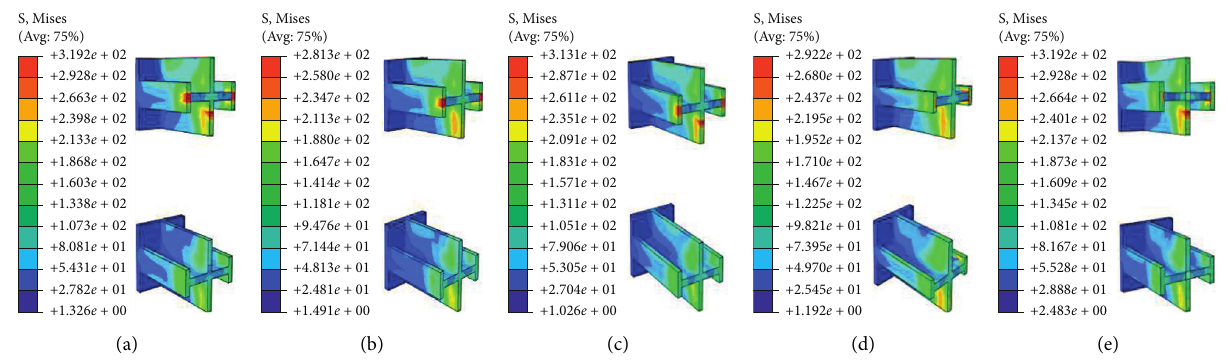
Figure 17: Stress nephogram of shear connectors: (a) PCB-SLCC-1; (b) PCB-SLCC-2; (c) PCB-SLCC-3; (d) PCB-SLCC-4; (e) PCB-SLCC-5.